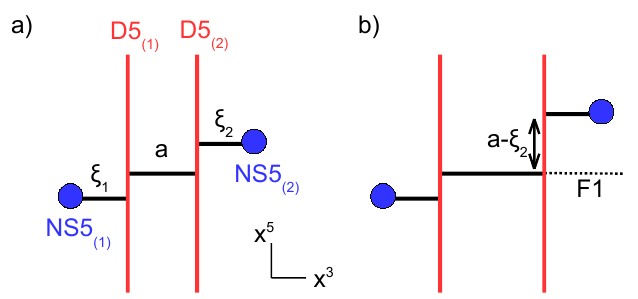
Figure 14 . a) Con(cid:12)guration associated to the FI deformation (cid:17) = (cid:24) 1 (cid:0) (cid:24) 2 ( x 3 ; 5 plane). b) Brane setup inserting the operator Y = Z 2 2 + (cid:24) 2